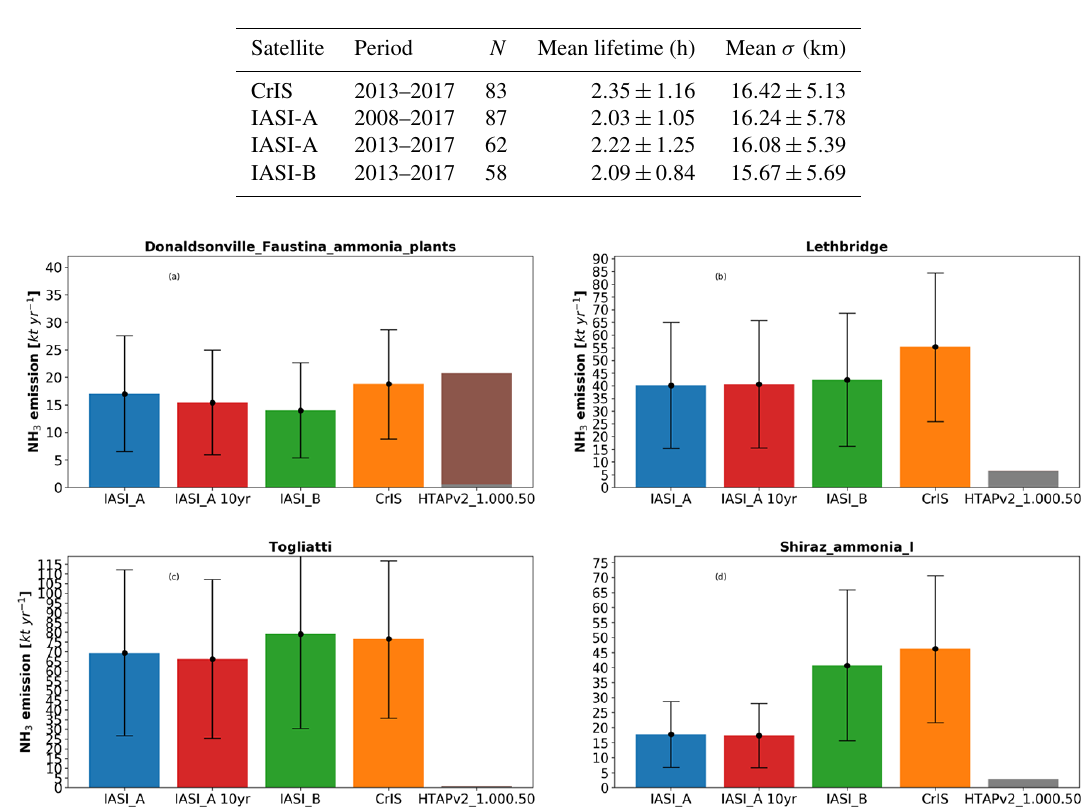
Figure 6. Comparison of the IASI-A (5 years, blue; 10 years, red), IASI-B (green) and CrIS (orange) emission estimated using fixed parameters for lifetime and σ , and the corresponding total emission found in the HTAPv2 inventory for a square 1.00 ◦ × 0.50 ◦ (long, lat) surrounding the location. The grey part of the bar indicates the agricultural emission total, while the brown section represents all other